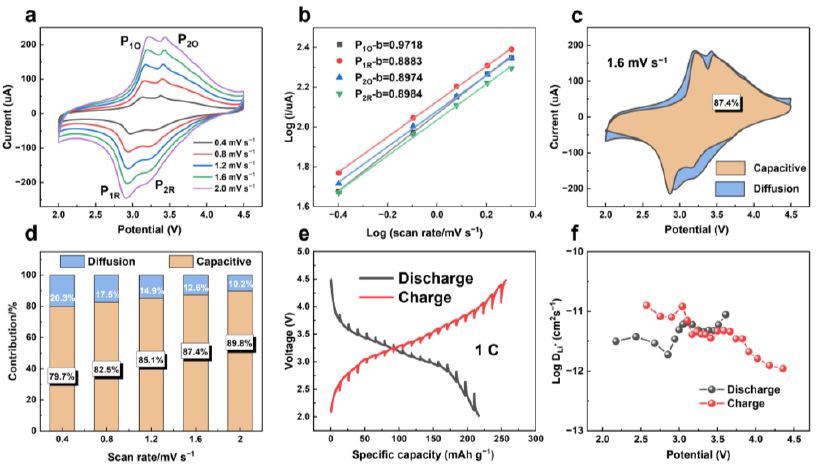
Figure 5. Kinetic features of Li + storage mechanism in FeF 3 @C LIBs. ( a ) CV curves at the sweep rates of 0.4 – 2.0 mV s −1 . ( b ) Determination of the b-value by the relationship between the characteristic peak current and different scan rates. ( c ) Percentage contribution of capacitive and diffusion to ca- pacity in FeF 3 @C LIBs at 1.6 mV s −1 . ( d ) Separation of capacitive contributions and diffusion-con-